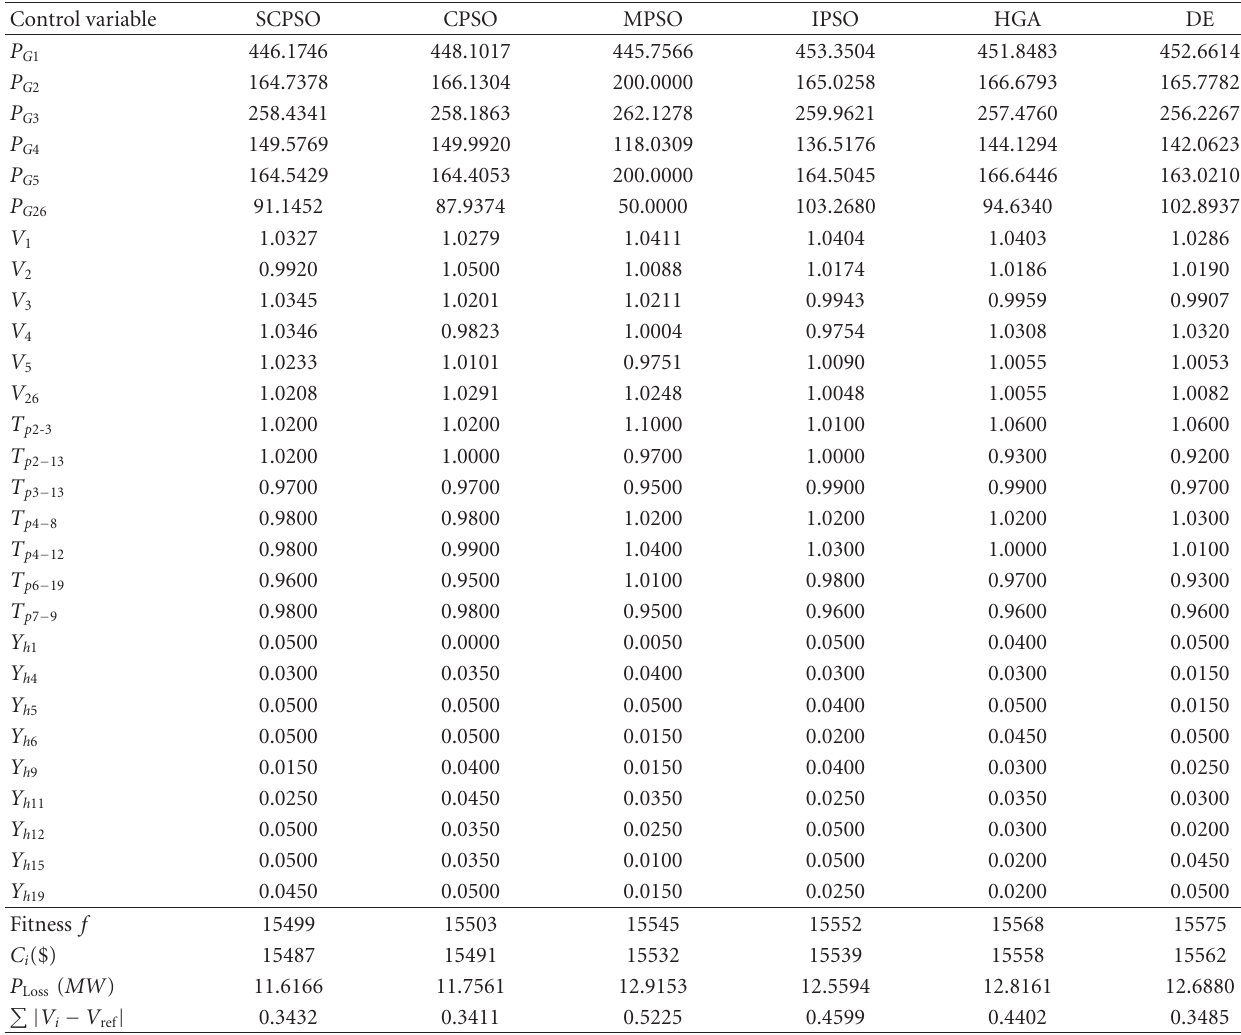
(a) Optimal settings of control variables in 26-bus